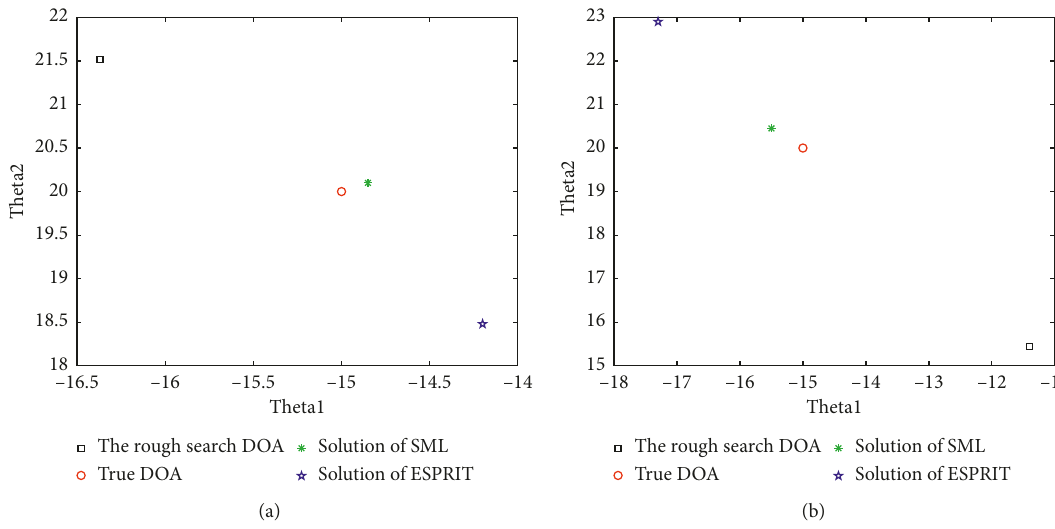
Figure 2: The solution of SML, ESPRIT, and the rough search DOA. (a) Noncoherent case: all the signals are independent. (b) Coherent case: two signals are fully